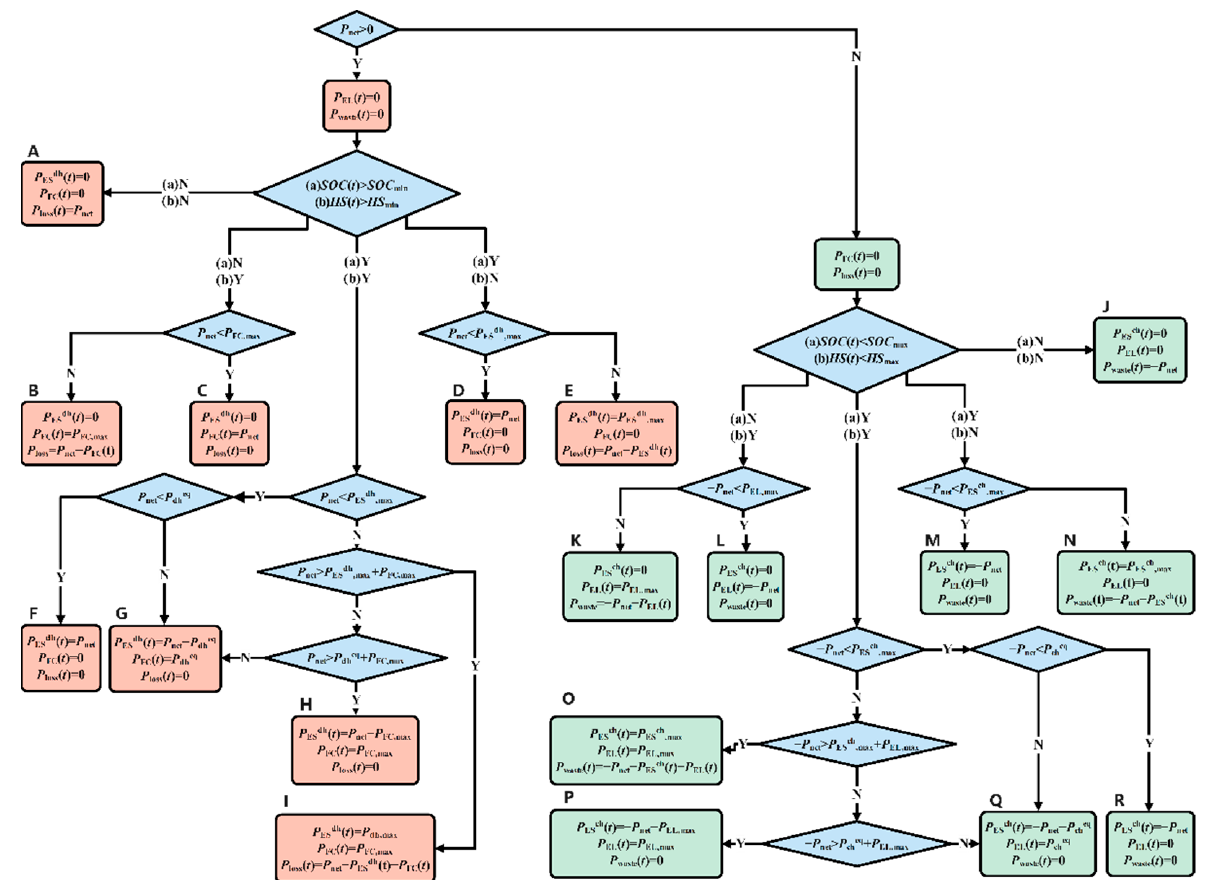
Figure 3. Optimal scheduling strategy considering the minimum operating cost of energy storage equipment. 4.3. Optimal Allocation Algorithm for Source and Storage Capacity of